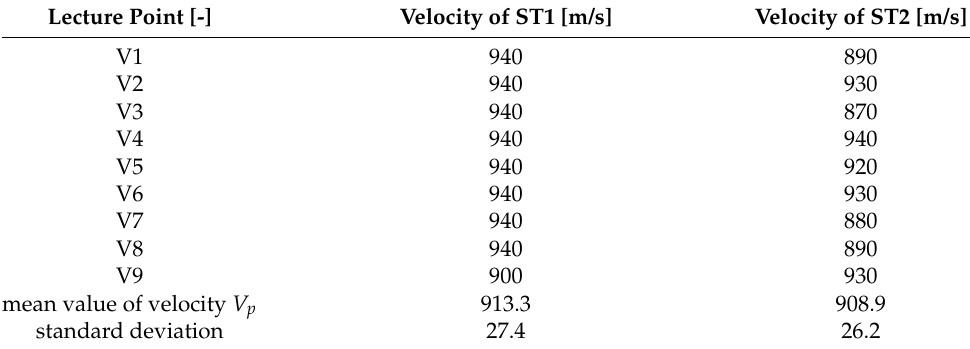
Table 1. Results of the Sonic Tests (ST1, ST2). Lecture Point [-] Velocity of ST1 [m/s] Velocity of ST2